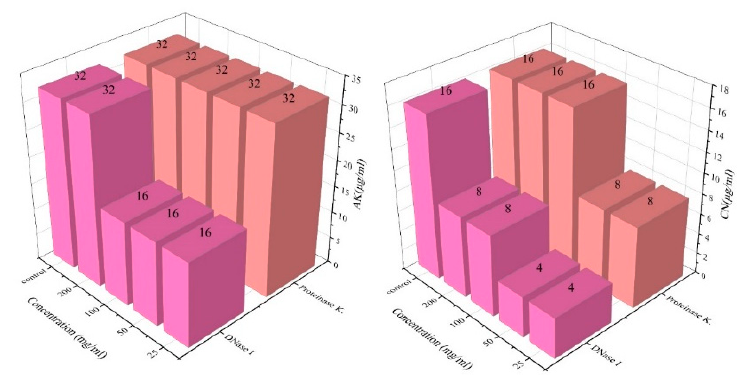
Figure 3. Changes in the BIC of V. parahaemolyticus treated with enzymes.